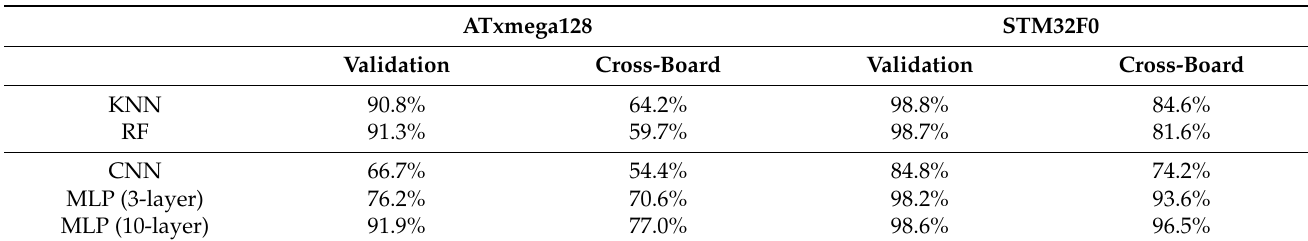
Table 3. Instruction recovery accuracy using machine learning and deep learning